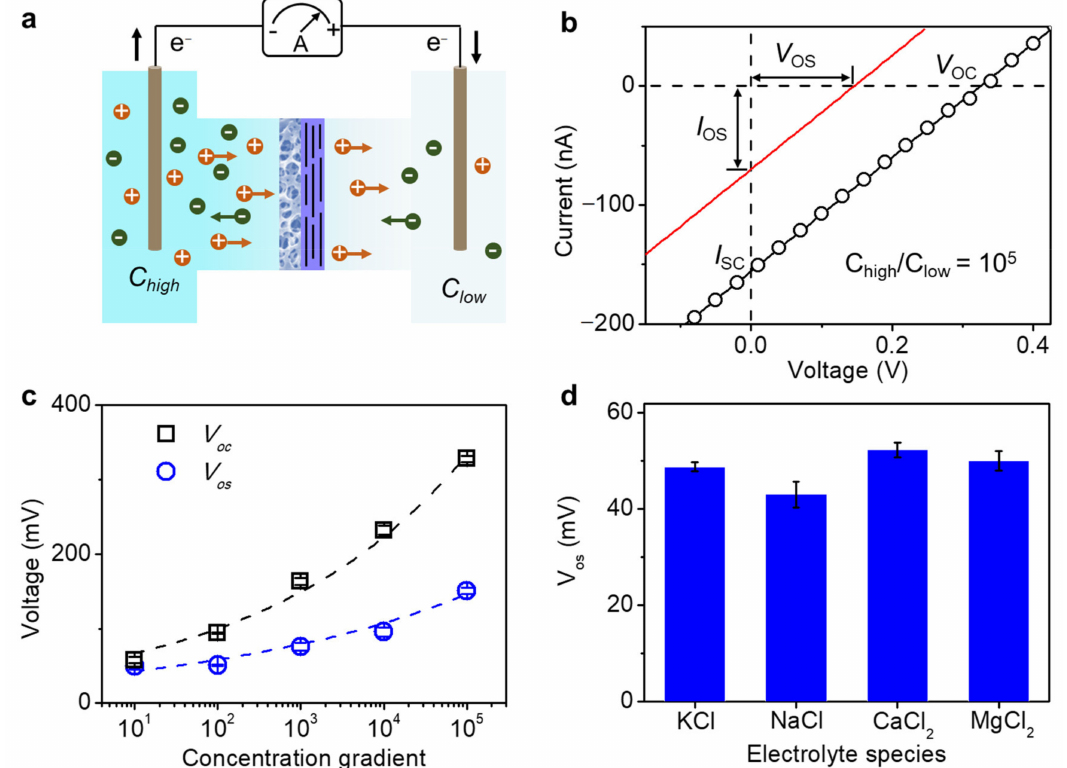
Figure 4. Salinity gradient power generation: ( a ) scheme of the device; ( b ) current–voltage characTable 105. across the membrane. The contribution from the redox reaction on the electrodes is subtracted from the measured current (black line), resulting in the red line, which represents the pure electroosmotic contribution. V oc and I sc are the open-circuit voltage and short-circuit current, respectively; V os and I os are osmotic voltage and current; ( c ) the open-circuit voltage and the osmotic potential of GO membrane as a function of concentration gradients (the low side is 1 µ M); ( d ) the osmotic potential of GO–CA heterogeneous membrane measured in different electrolytes under a 100-fold concentration